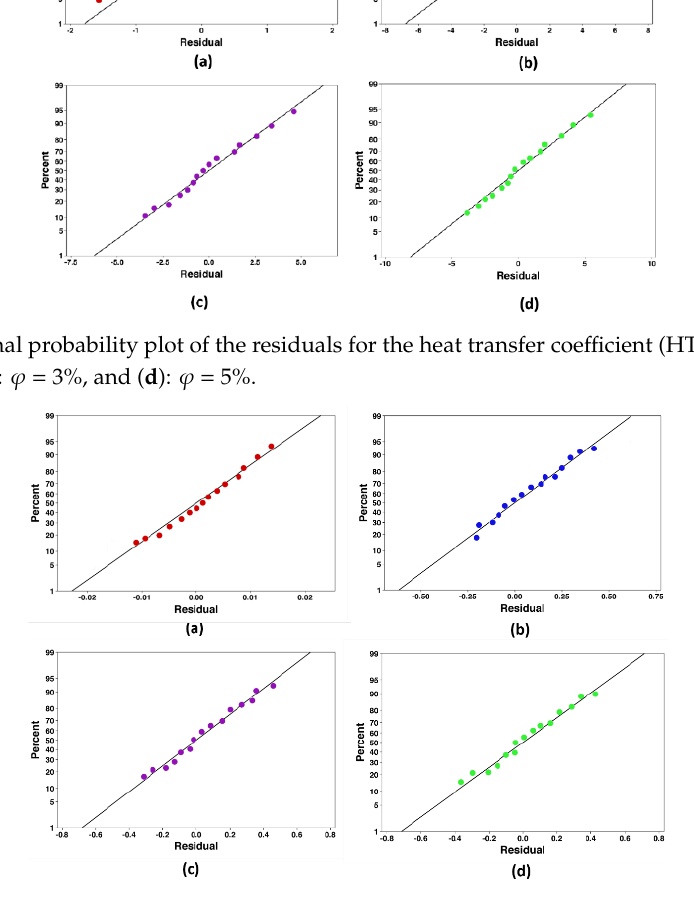
Table 9. Correlations of the heat transfer coe ffi cient and pumping